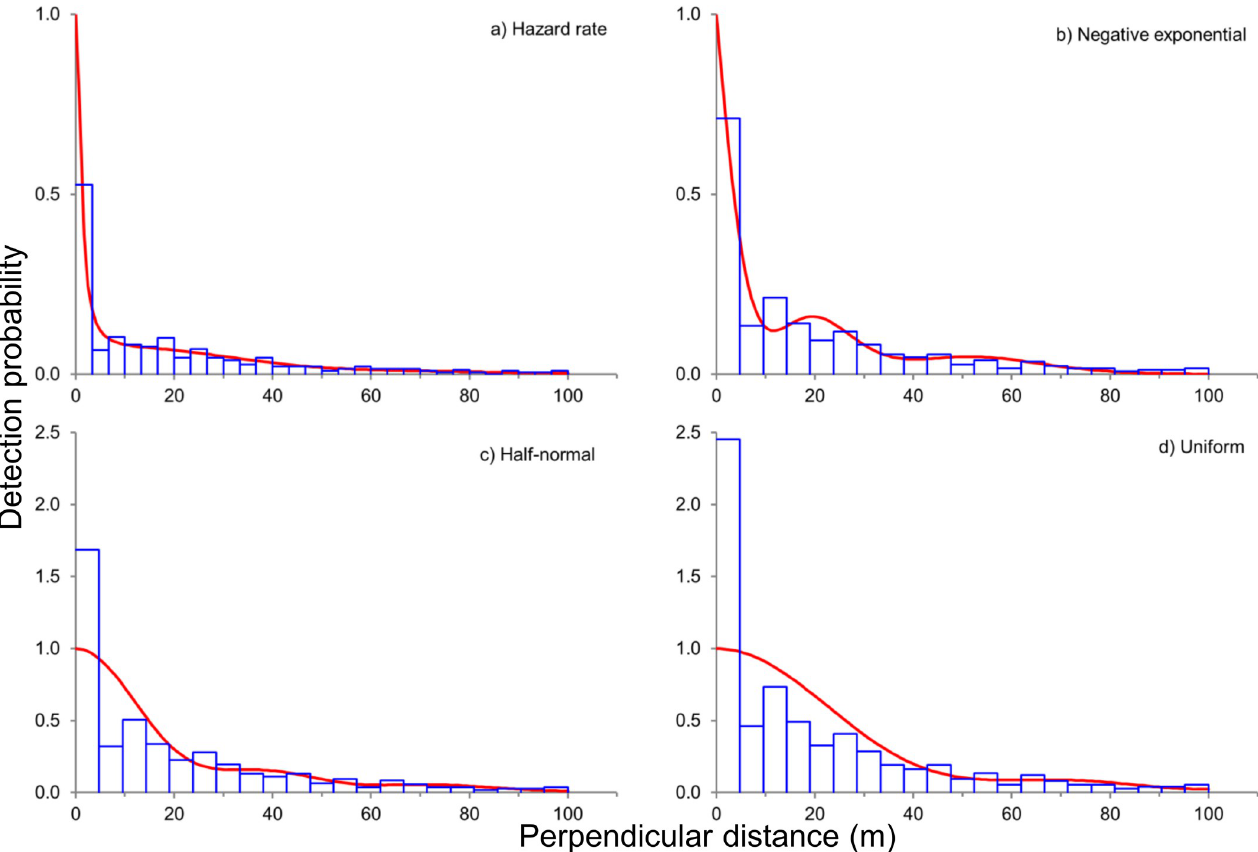
Fig 3. Detection functions (red line) of conventional distance sampling models for olive baboons sighted along road transects in Lake Manyara National Park (Tanzania). The histograms (blue bars) show the observed frequency of sightings in each distance bin; detection functions were modeled using a) hazard rate, b) negative exponential, c) half-normal, and d) uniform key functions with cosine series